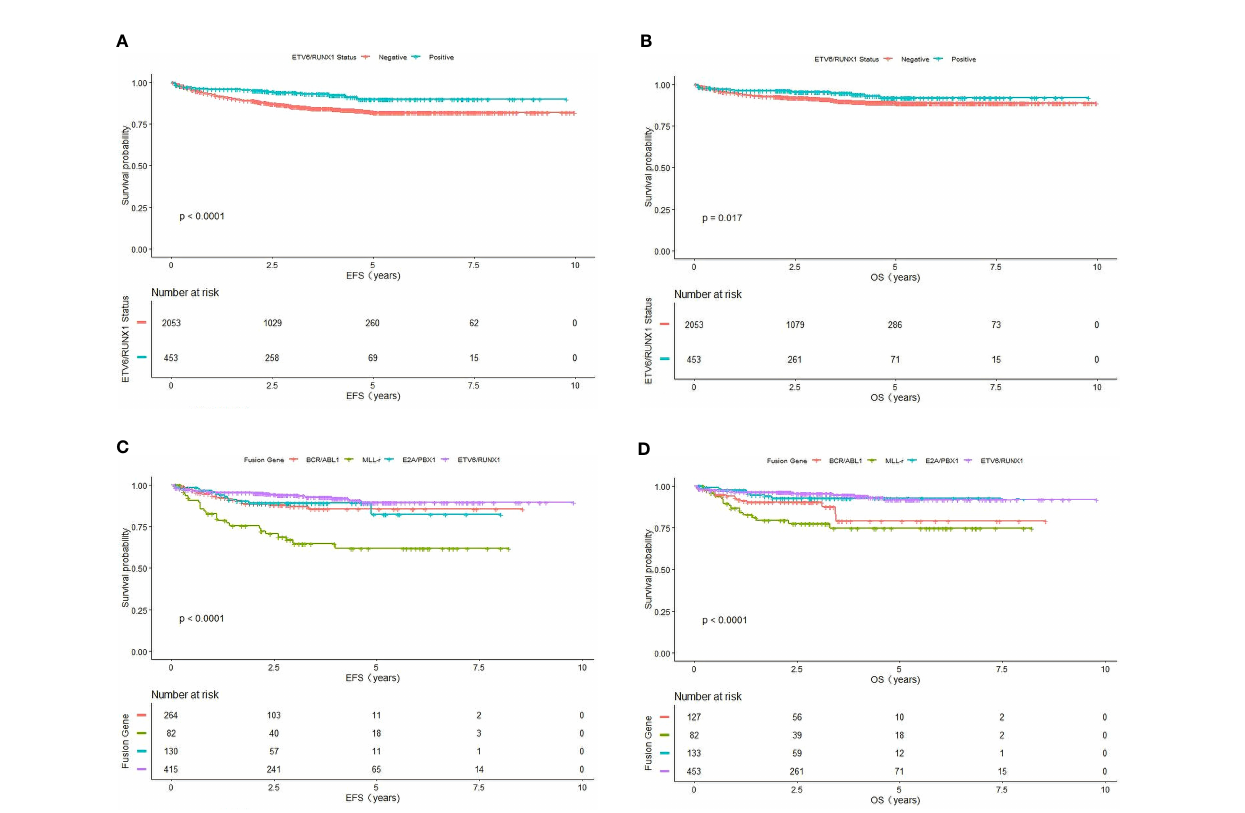
FIGURE 1 | Survival cures of fusion gene. (A) The cumulative event-free survival of ETV6/RUNX1-positive and ETV6/RUNX1-negative patients. (B) The cumulative overall survival of ETV6/RUNX1-positive and ETV6/RUNX1-negative patients. (C) The cumulative event-free survival of four fusion gene patients. (D) The cumulative overall survival of four fusion gene